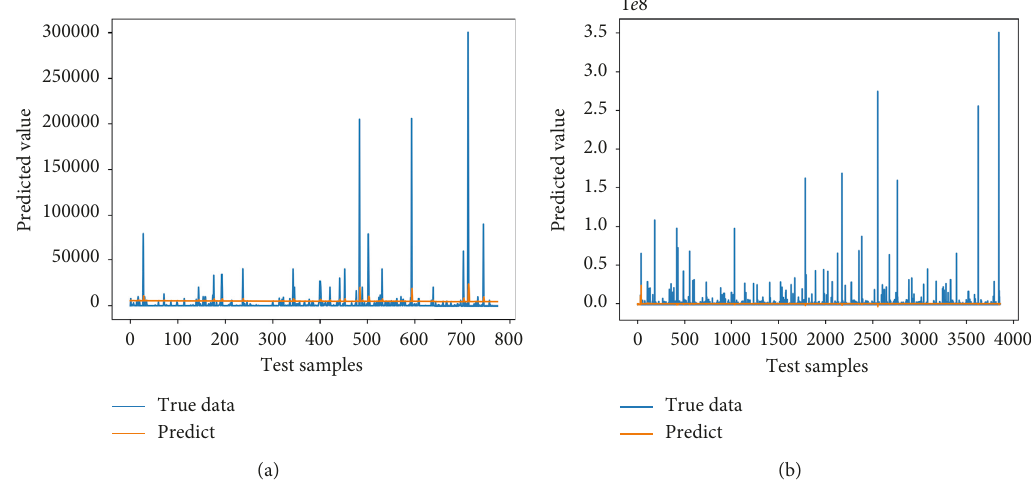
Figure 7: Testing performance of ARIMA on (a) UCI seismic bumps and (b) AAIA ′ 16